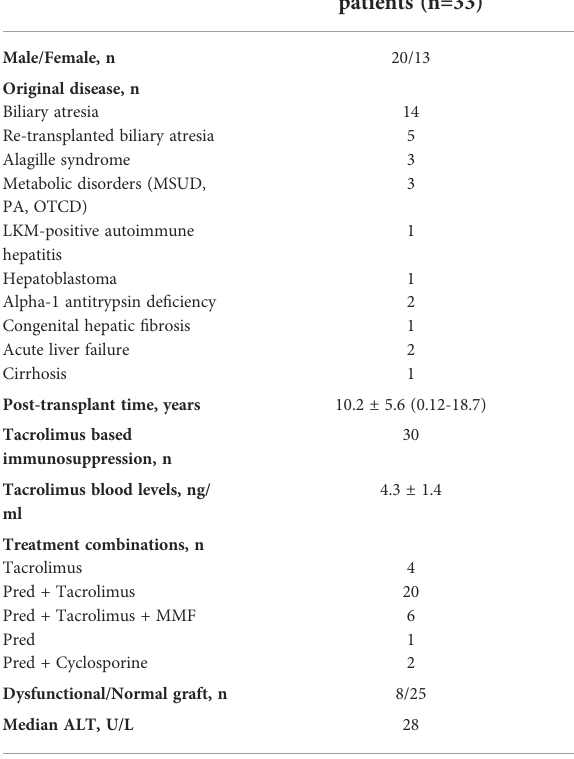
TABLE 1 Epidemiologic and clinical features in our cohort of young- adult liver transplanted patients.